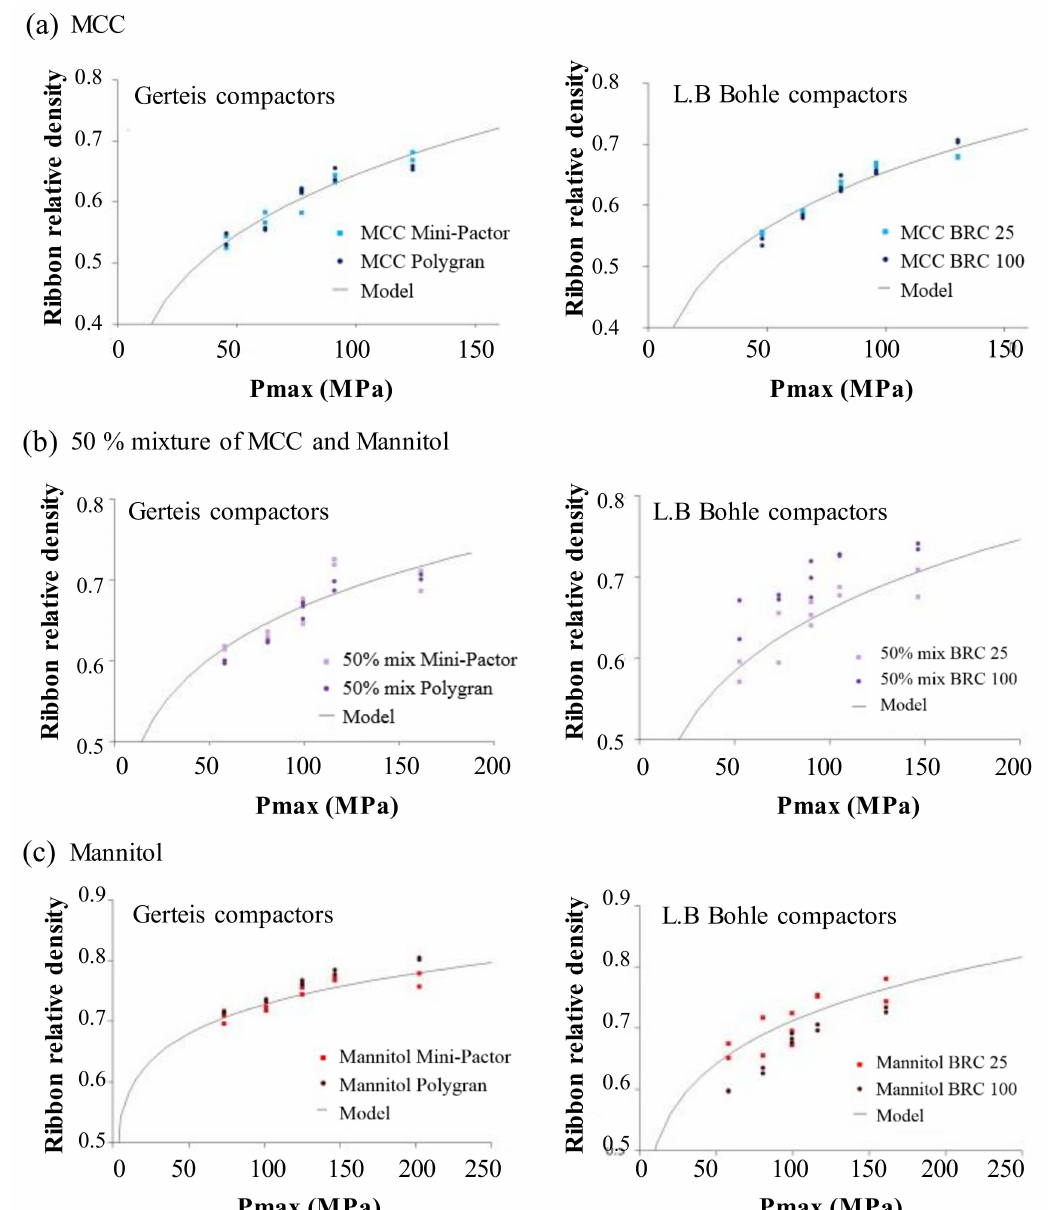
Figure 12. Comparison of the relative ribbon density of model predictions and experimental results on two roller compactors (Gerteis and L.B. Bohle compactors) [17]: the formulations used were ( a ) microcrystalline cellulose (MCC); ( b ) a 50% mixture of MCC and mannitol; and ( c ) mannitol. The figures were slightly modified, with permission from